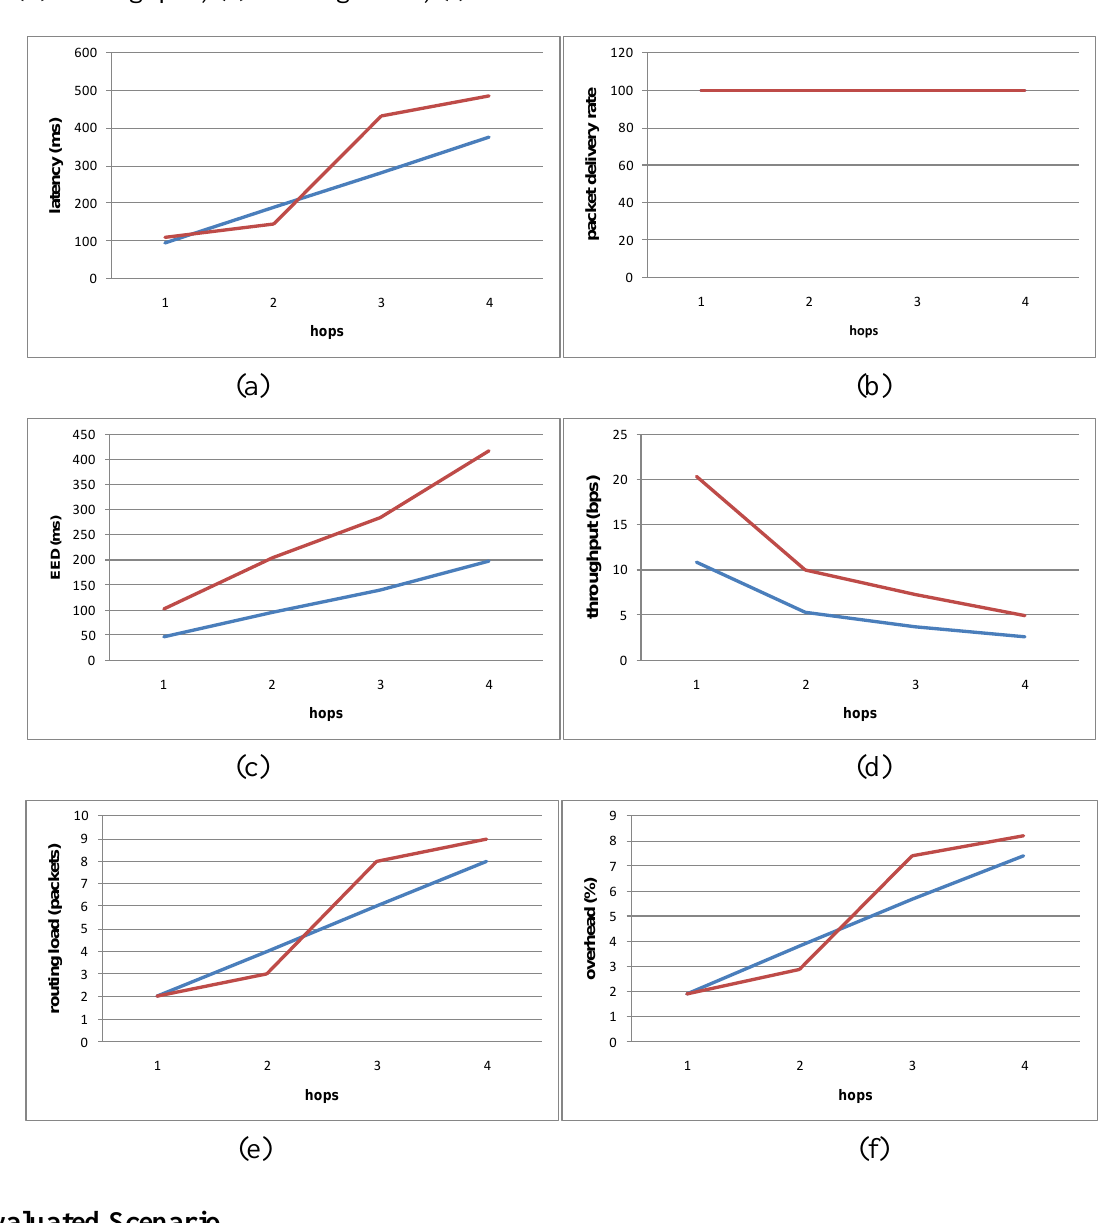
Figure 5. (a) Route Discovery Time; (b) Packet Delivery Ratio; (c) End-to-End Delay; (d) Throughput; (e) Routing Load; (f)